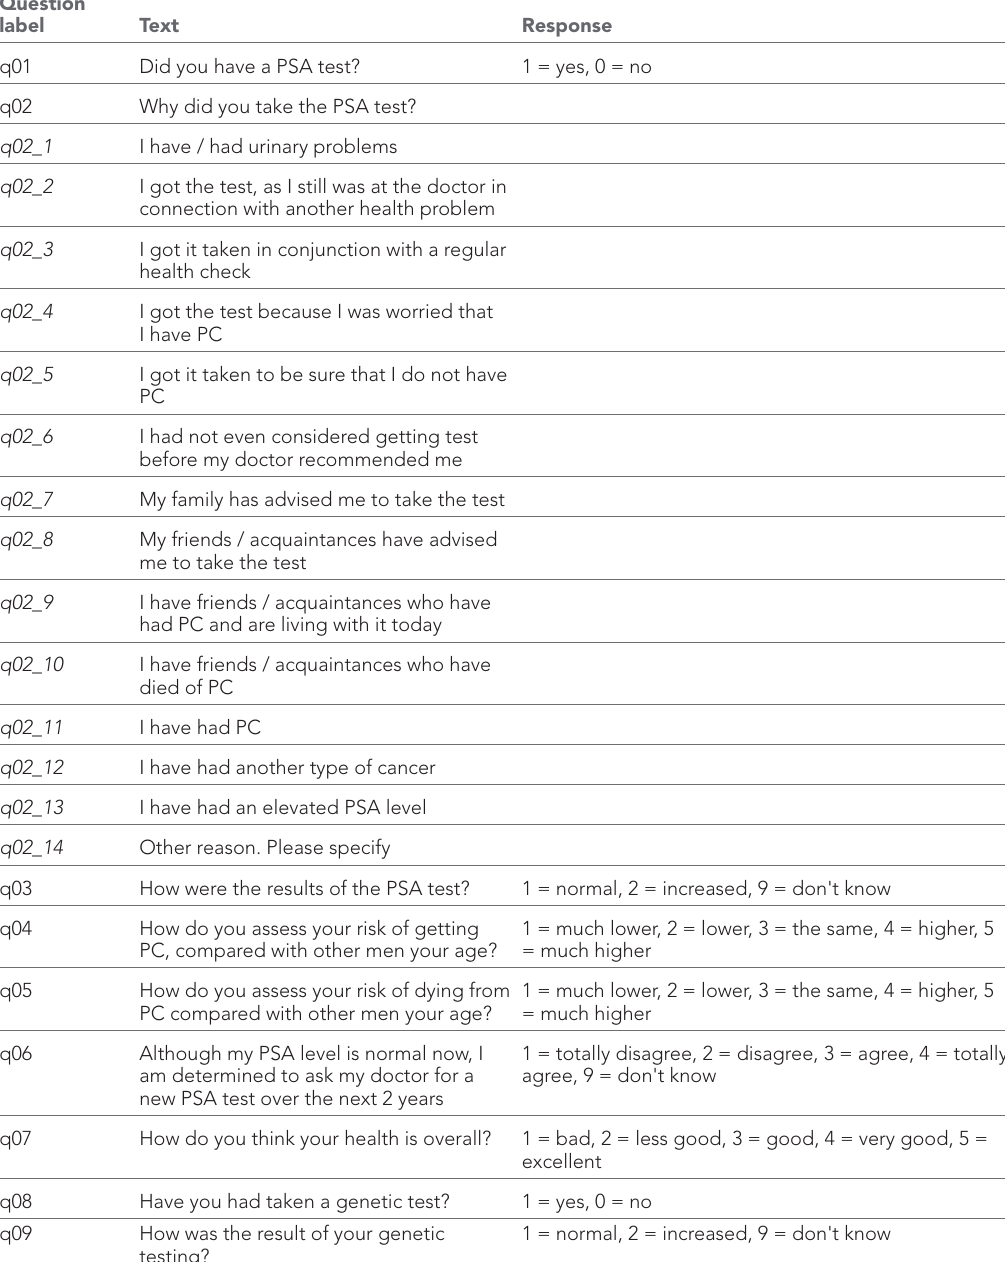
Table 1 Summary of patient questionnaire used in this study. The full questionnaire participants received is available on